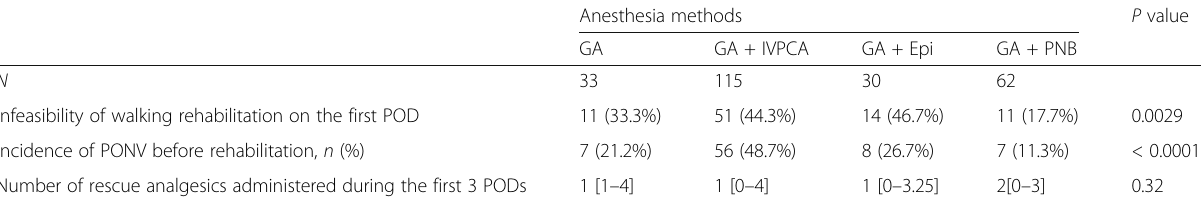
Table 3 Post hoc analysis between anesthesia methods and postoperative outcome